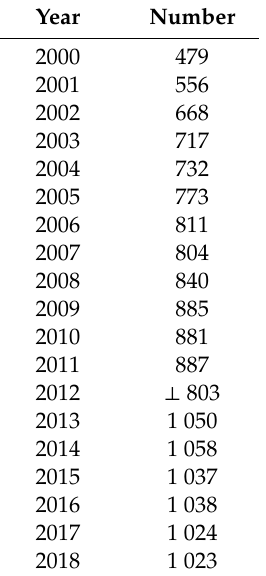
Table 1. Art galleries and other venues for temporary